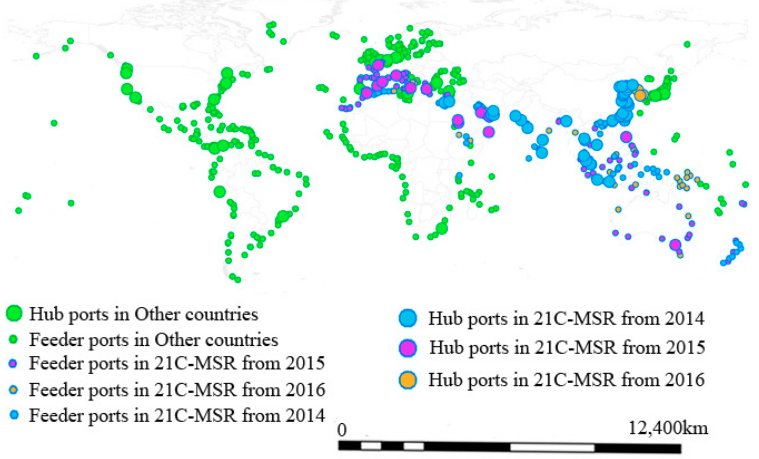
Figure 8. Container ports with low stability in 21C-MSR and other countries.